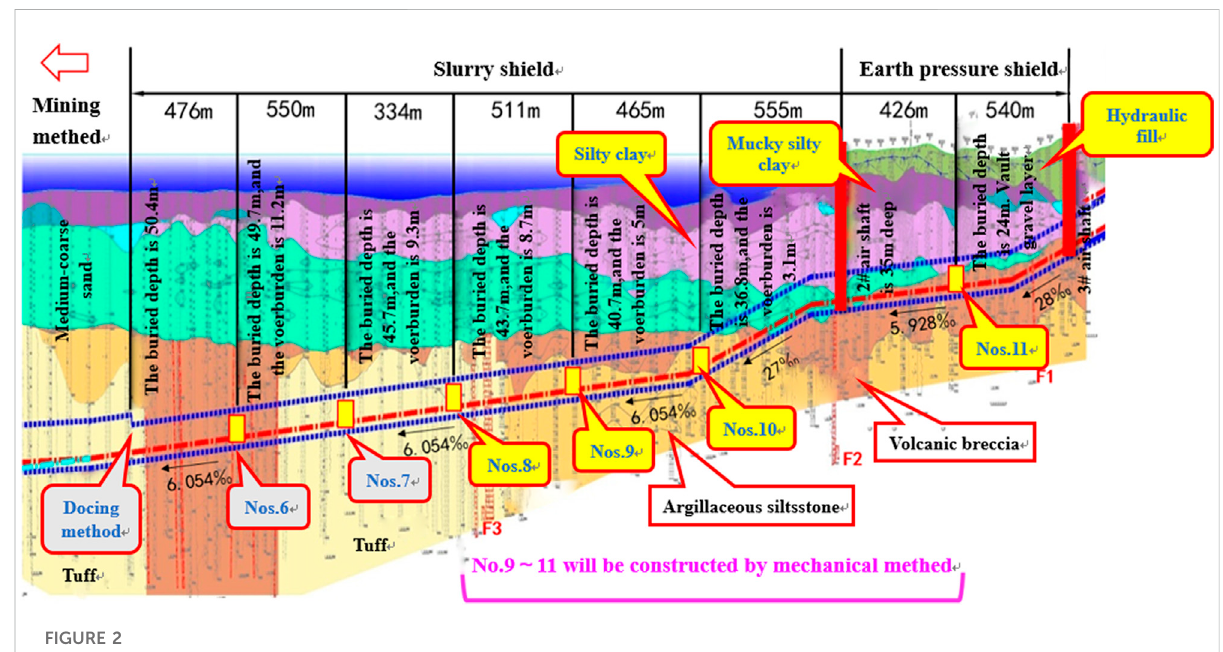
FIGURE 2 Geological pro fi le of the connecting aisle